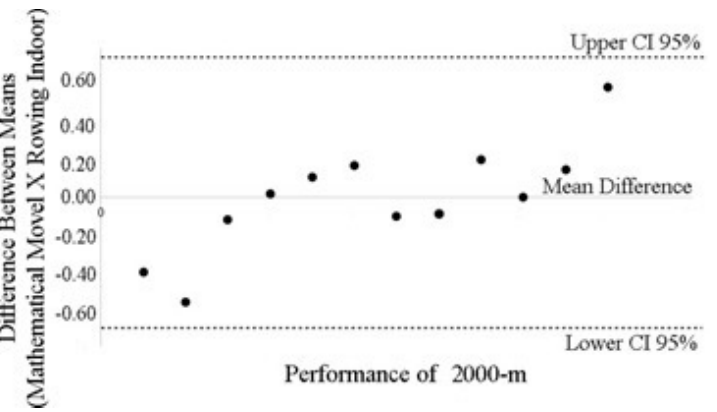
Figure 2. Bland-Altman Plot. CI 95%: Confidence Interval of 95%. M: Meters.